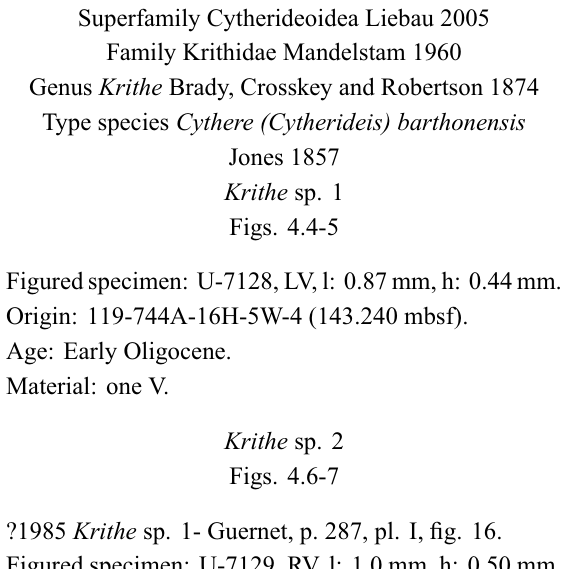
?1985 Krithe sp. 1- Guernet, p. 287, pl. I, fig. 16. Figured specimen: U-7129, RV, l: 1.0 mm, h: 0.50